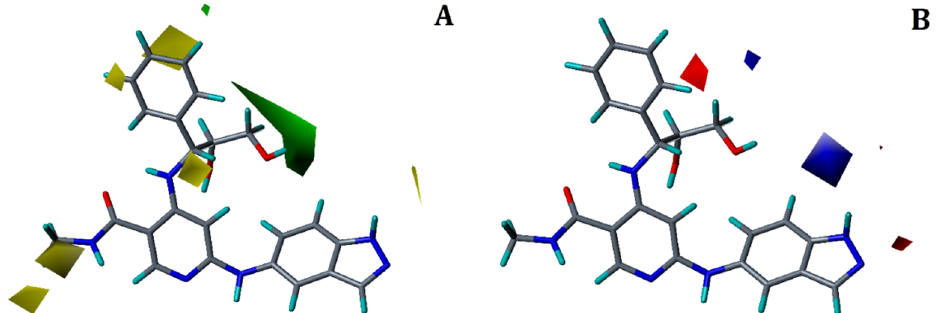
Figure 7. Contour maps for the selected RF-CoMFA model. ( A ) Steric contour map; ( B ) electrostatic contour map green contour shows the regions favorable for bulky substitutions and yellow contours shows the regions unfavorable for bulky substitutions; Blue contour favors electropositive substitutions while red contour favors electronegative substitutions.